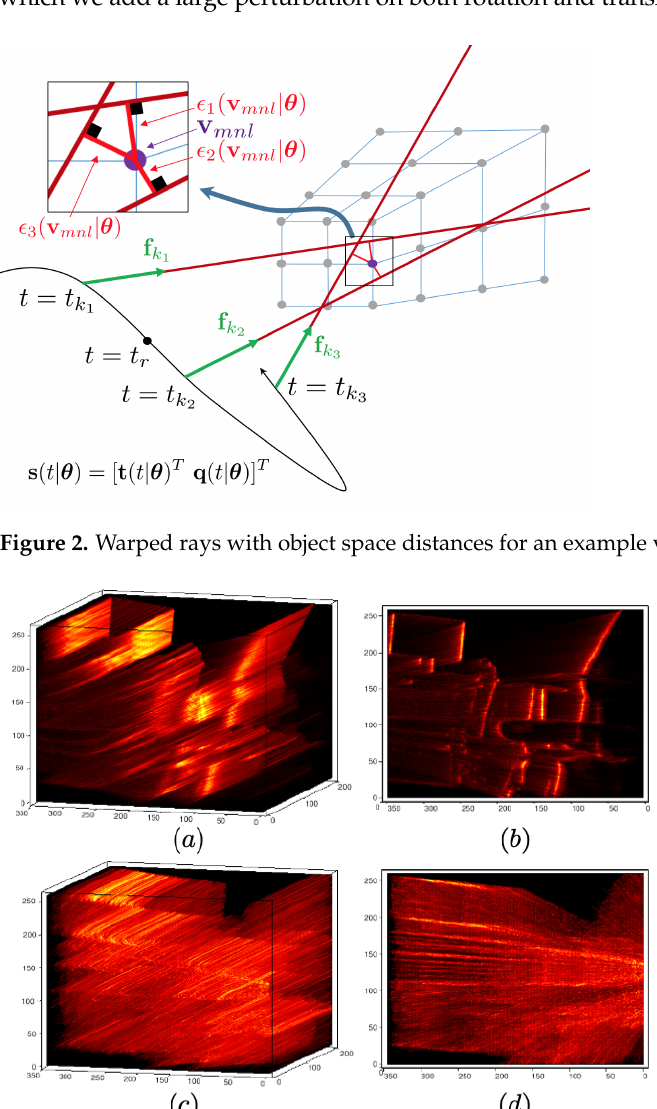
Figure 3. Volumetric ray density fields for correct ( a , b ) and wrong ( c , d ) motion